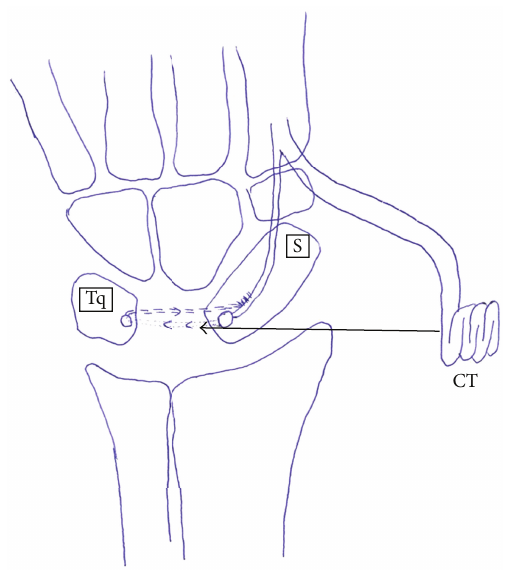
Figure 3: Schematic presentation of ligament reconstruction with tendon interposition arthroplasty (CT: coiled tendon; S: scaphoid; Tq: triquetrum; Ts: tendon strip for ligament